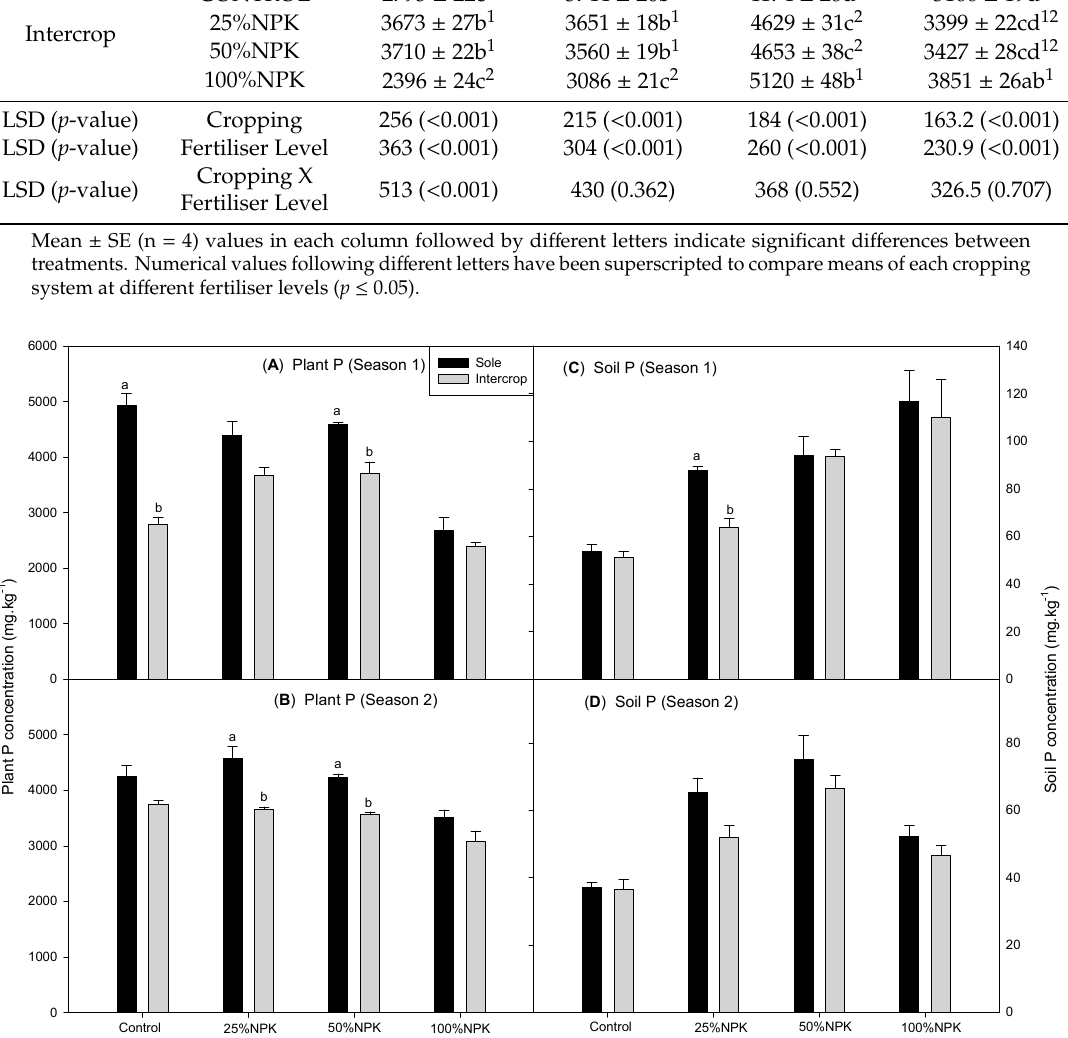
Figure 4. Two-way analysis of variance showing the e ff ects on ( A,B ) plant and ( C , D ) soil P concentration Figure 4. Two ‐ way analysis of variance showing the effects on ( A,B ) plant and ( C , D ) soil P concentration on rhizosphere of cowpea at four NPK levels in 2014/15 and 2015/16 seasons. Each bar represents the mean on rhizosphere of cowpea at four NPK levels in 2014 / 15 and 2015 / 16 seasons. Each bar represents the (mean ± SE). Letters in each fertilizer treatment shows significant differences at p ≤ 0.05 in sole or mean (mean ± SE). Letters in each fertilizer treatment shows significant di ff erences at p ≤ 0.05 in sole intercropping. or